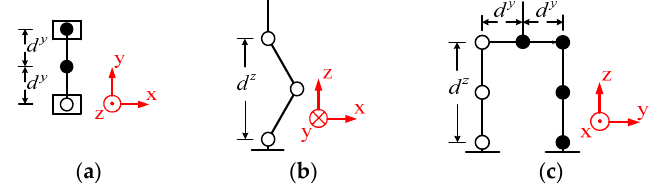
Figure 11. Standing posture: ( a ) horizontal plane; ( b ) sagittal plane; ( c ) frontal plane.